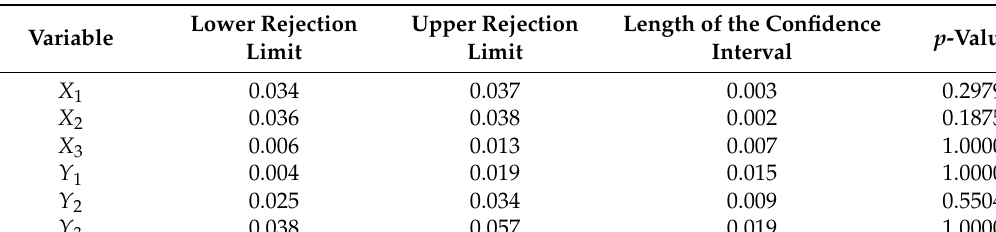
Table 2. Rejection limits at the significance level α = 5%.